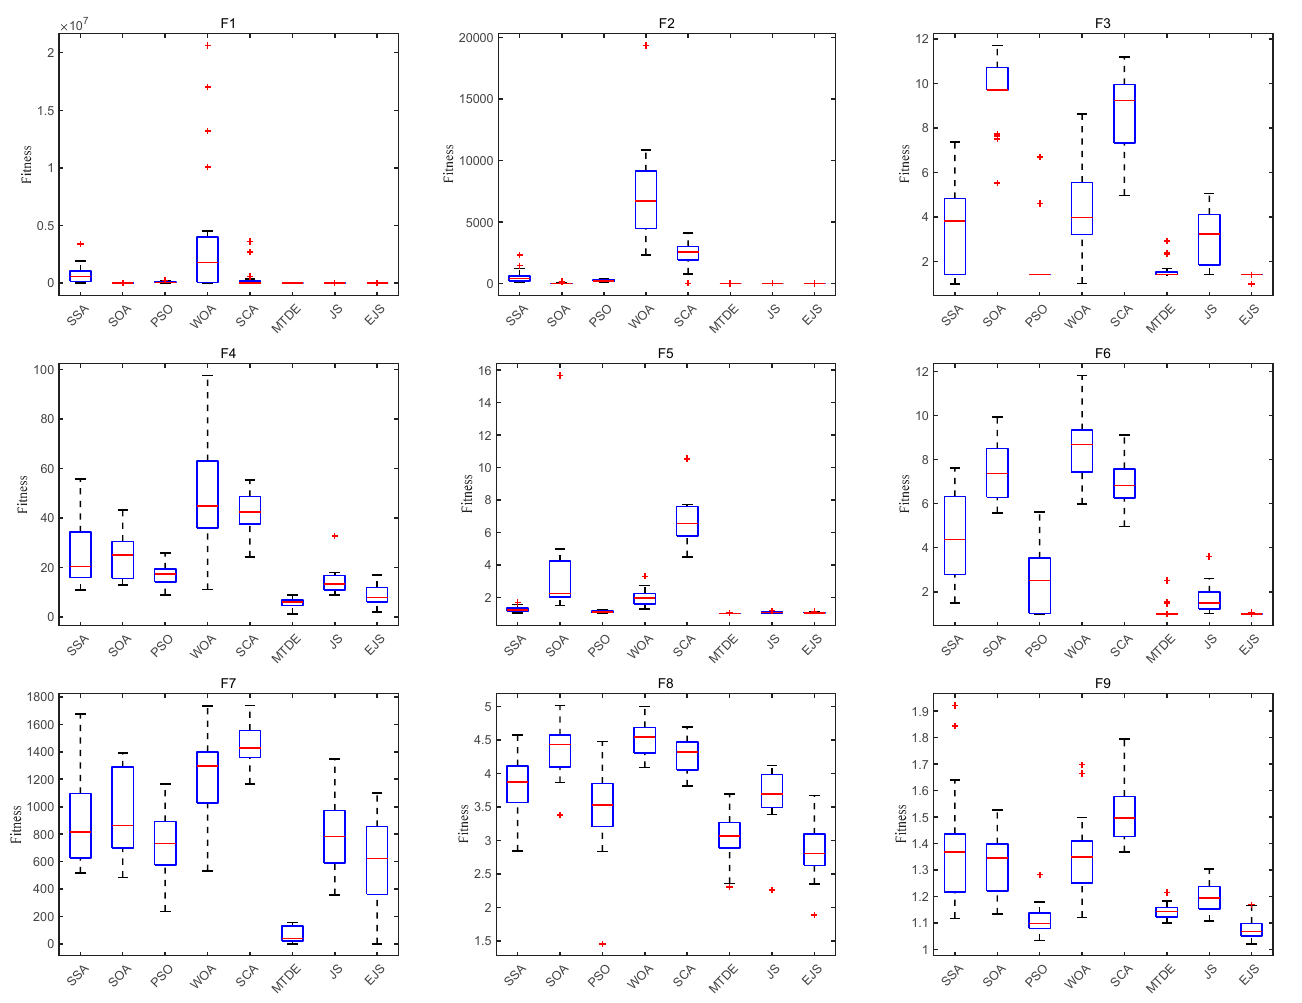
Figure 5. Box plots of all algorithms on the CEC2019 test set.